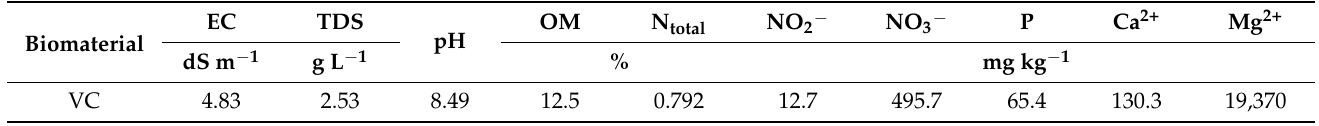
(Table 2). EC, TDS, pH, organic matter (O.M.), total nitrogen (TN), NO 2 − , NO 3 − , P, Ca 2+ and Mg 2+ were quantified, [32–36]. Table 2. Physico-chemical analyses of vermicompost; CIBNOR, La Paz BCS, M é xico.